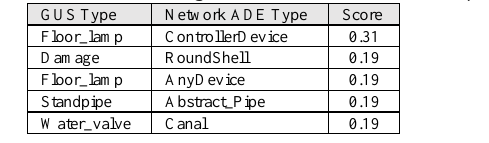
Table 5. Group By Type matching between GUS-